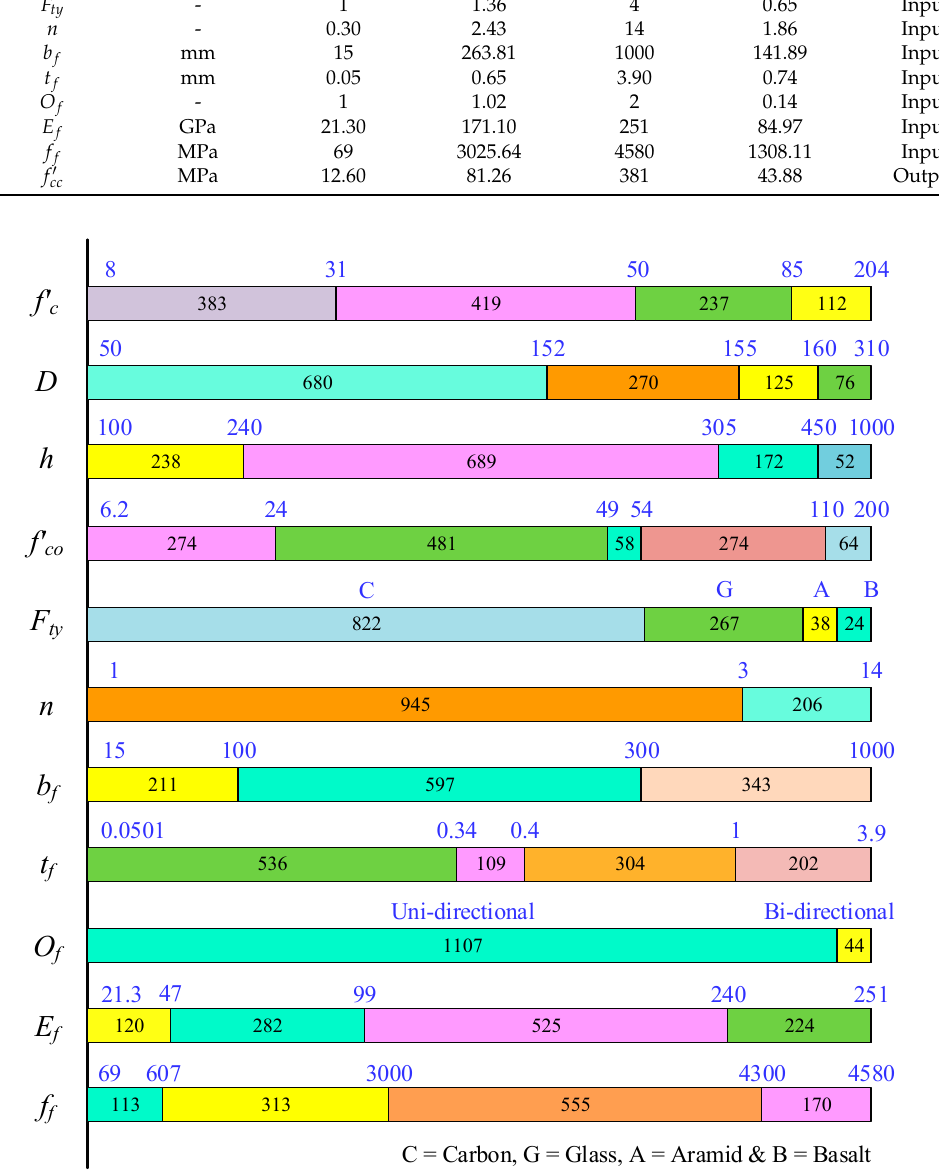
Figure 1. Details of input parameters.